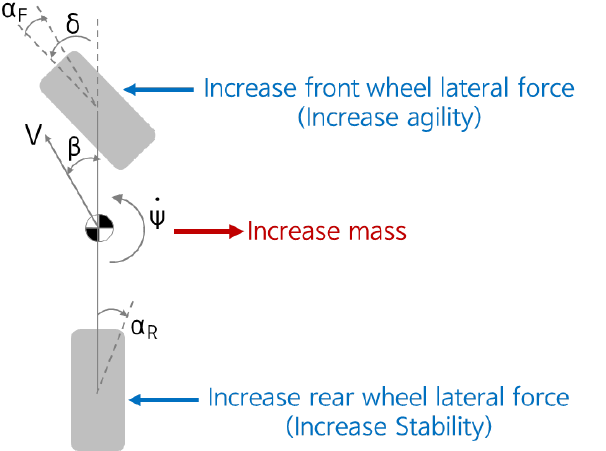
Figure 12. Centripetal force increase setting to cope with increased centrifugal force.